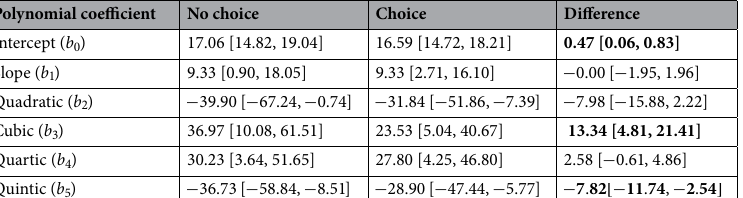
Table 1. Summary of the estimated coefficients (with 95% HDIs) of the polynomial for the choice and no-choice conditions, along with the estimated difference (95% HDI) between conditions for Experiment 1. Coefficients are standardized to make the scales comparable—raw coefficients can be obtained by dividing b n by the standard deviation of the time points for the corresponding term, SD ( t ◦ n (where t ◦ is element-wise power function, raising the values in t to the n th power) . Differences between choice and no-choice conditions that exclude zero are highlighted in